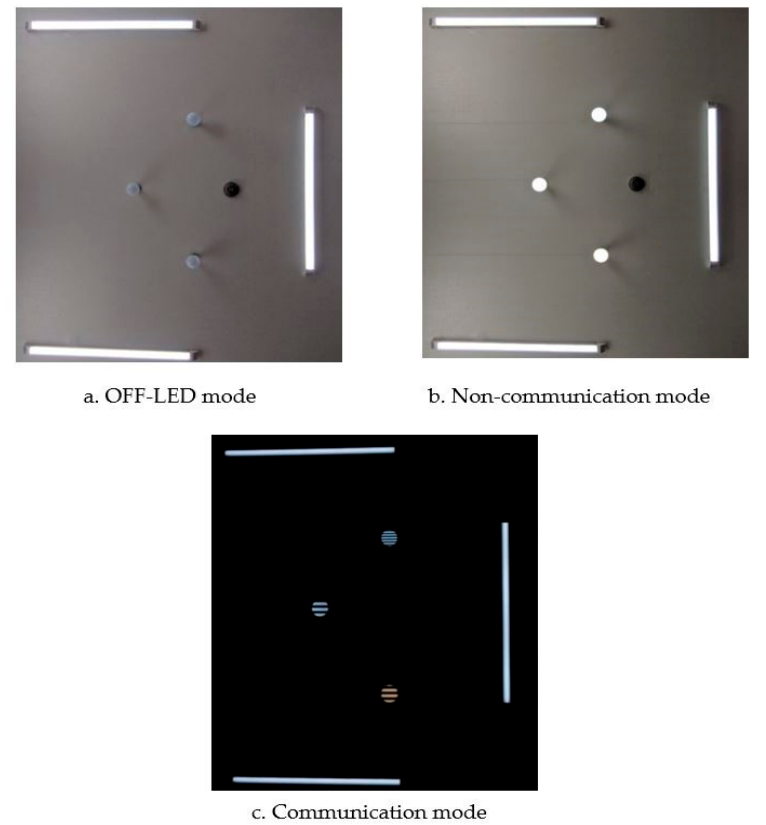
Figure 31. Evaluation experiment scenario. ( a ) Off state of LEDs scenario. ( b ) Illumination state of LEDs scenario. ( c ) Communication state of LEDs scenario.